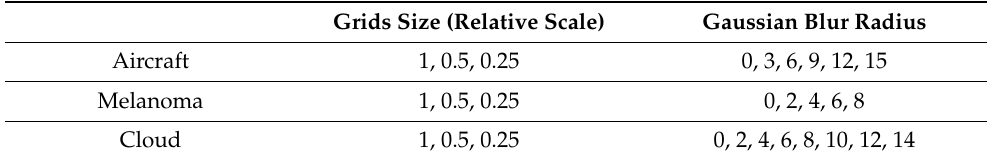
Table 1. Binary contour maps. Setting for assessing the robustness of DStr and DSize against grid size and Gaussian blur